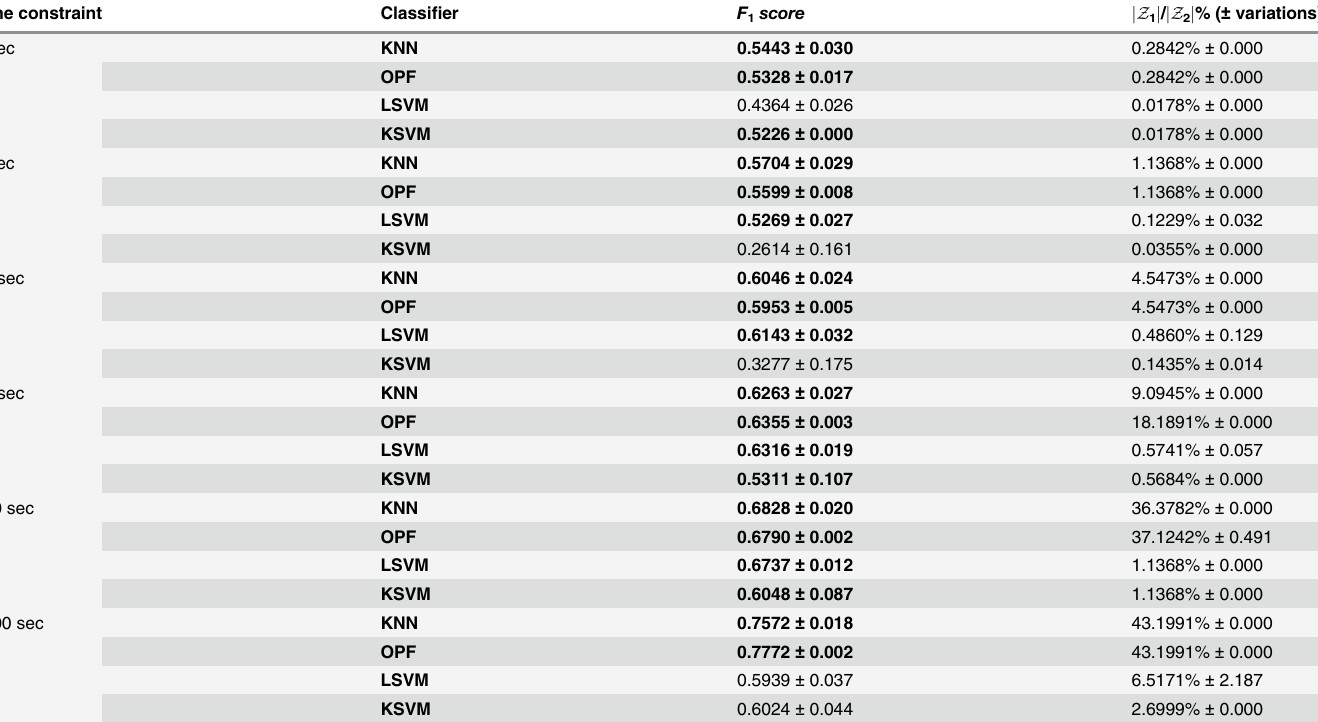
Table 3. Connect dataset: Predictivity performance over Z 3 and final training set size, j Z 1 j as a percentual of j Z 2 j , for each classification model and learning time constraint using the proposed